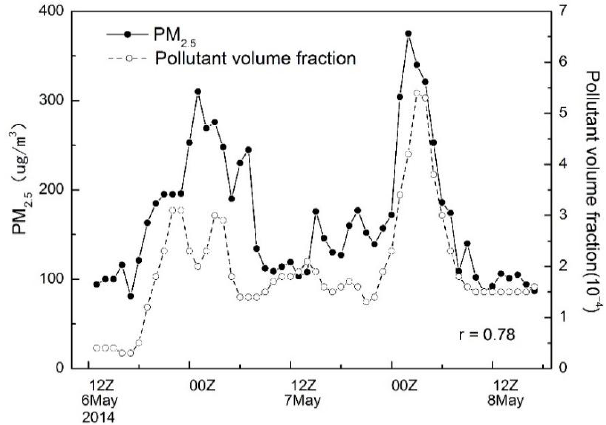
Figure 10. Hourly change in the simulated volume fraction of pollutants (10 − 4 ) and observed PM 2.5 concentration in Chengdu during the pollution event (notes: the volume fraction of pollutants was the simulation result obtained based on the mesh closest to the comprehensive substation at the Chengdu University of Information Technology).